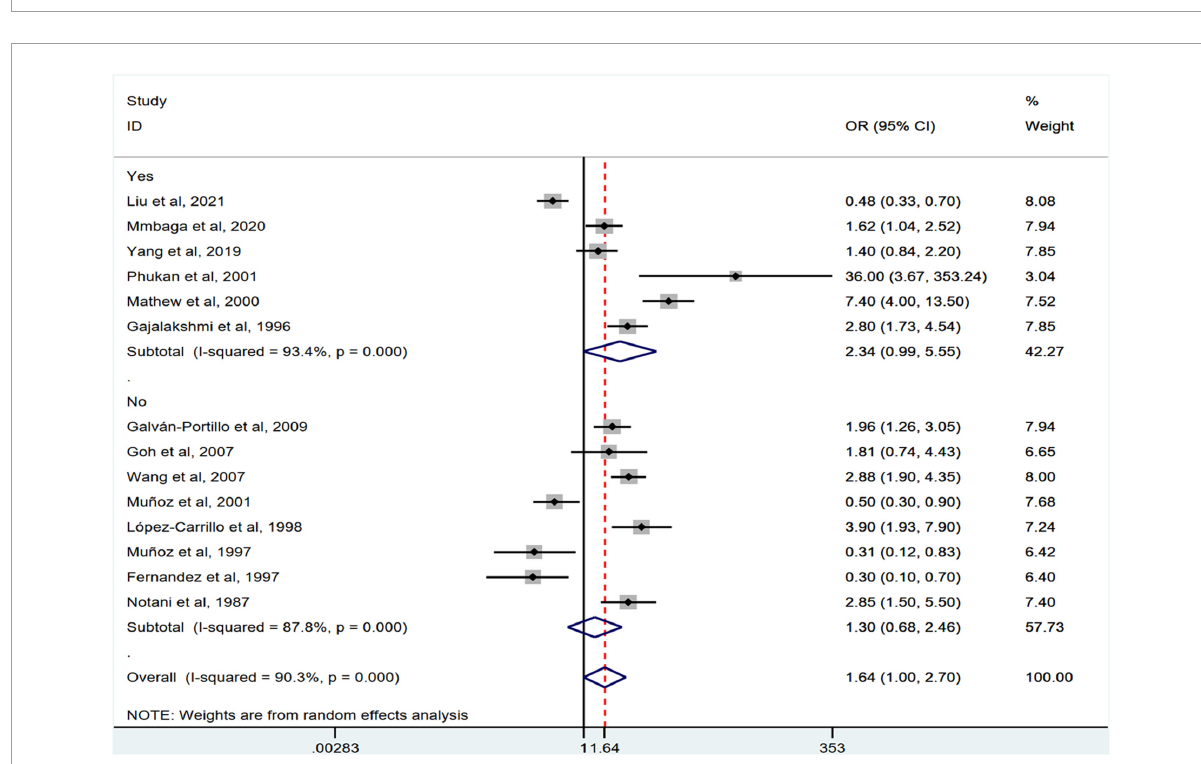
FIGURE9 ‘Subgroup analysis showing associations between chili pepper consumption and the risk of GI cancers based on the adjustment for